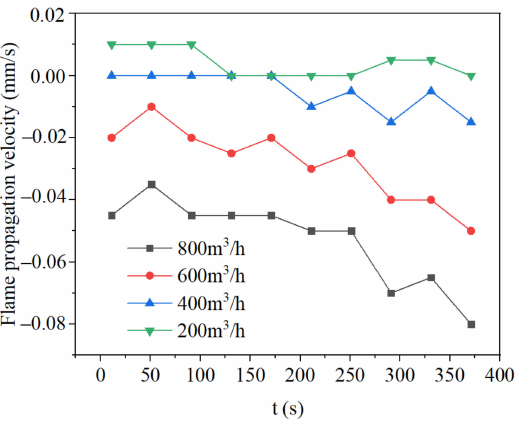
Figure 19. Variation of flame propagation velocity with time at different inlet flow rates with X CH = 0.6%. 4